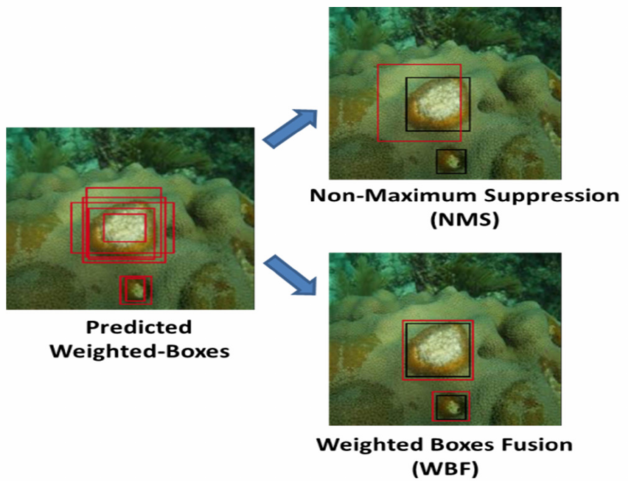
Figure 15. Comparison results of the NMS algorithm with the WBF